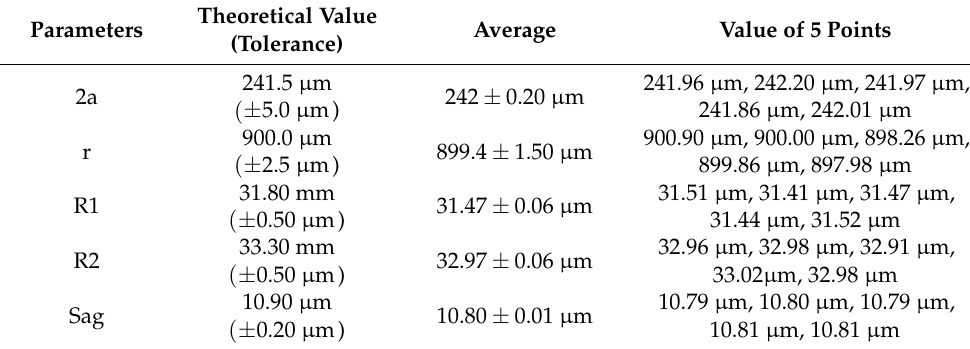
Table 1. Key parameter measurement results.